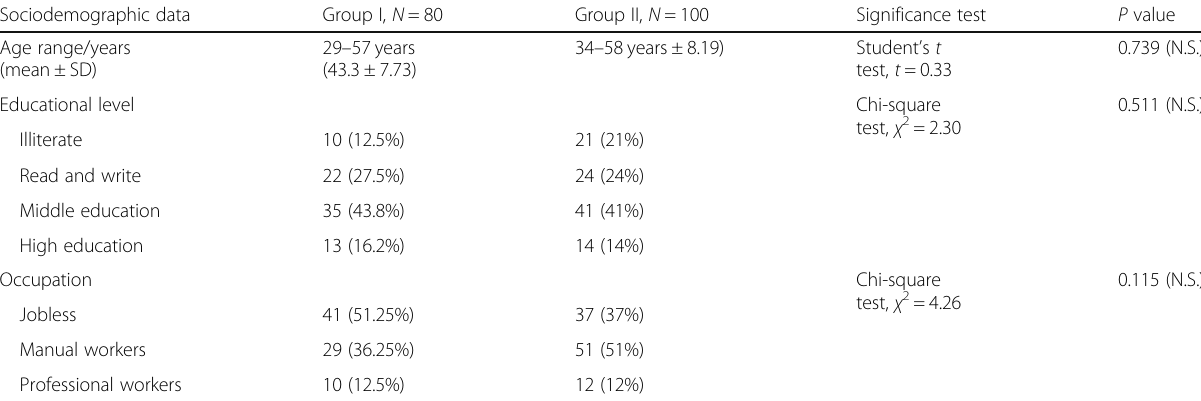
Table 1 Sociodemographic data among patients of groups I and II Sociodemographic data